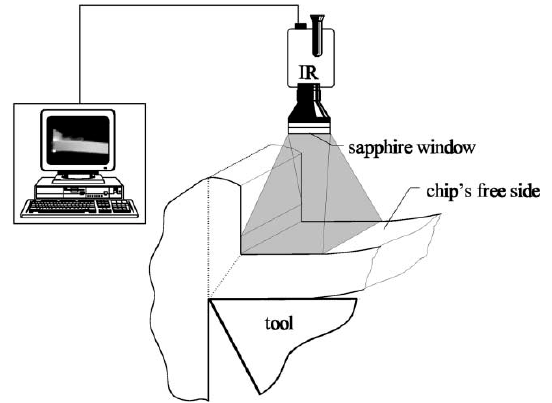
Figure 3. Schematic drawing of the temperature measurement with an infrared camera on the chip’s free side in orthogonal cutting [7].